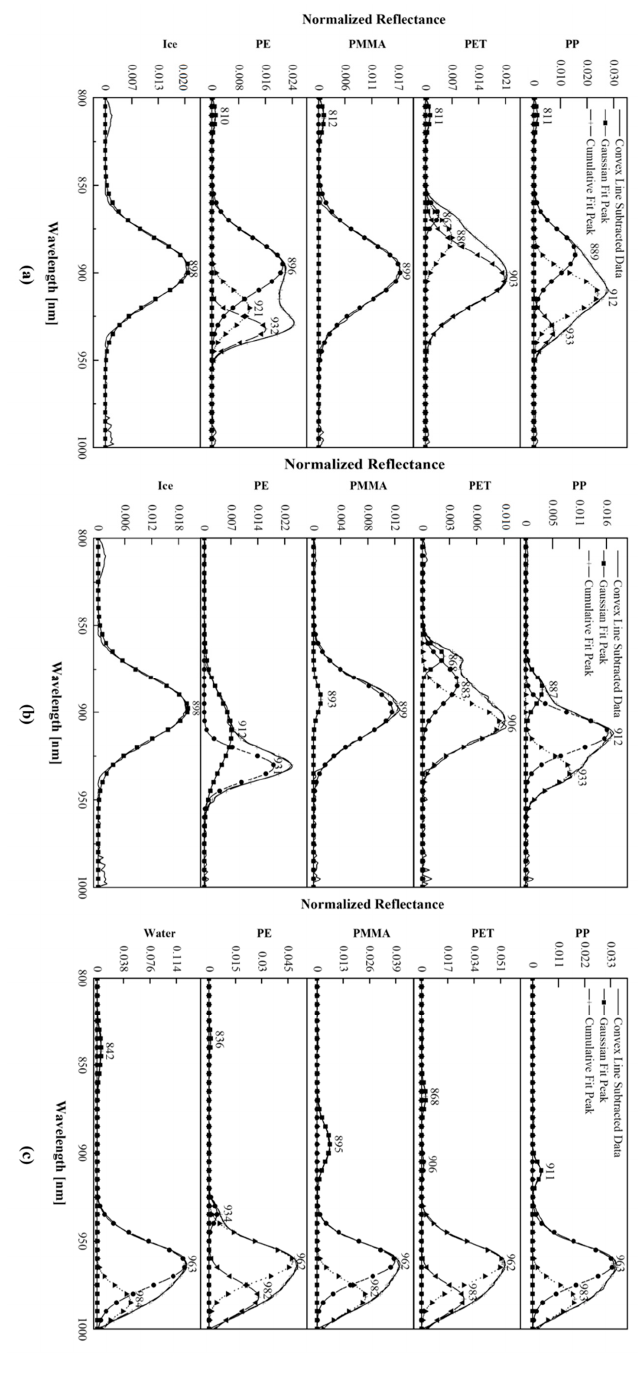
Figure 6. The spectral of the characteristic peak wavelength of plastic polymers ( a ) exposed to ice, ( b ) covered with ice, and ( c ) floating on water.